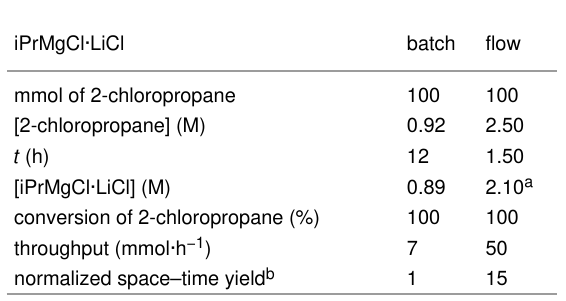
iPrMgCl ⋅ LiCl batch flow mmol of